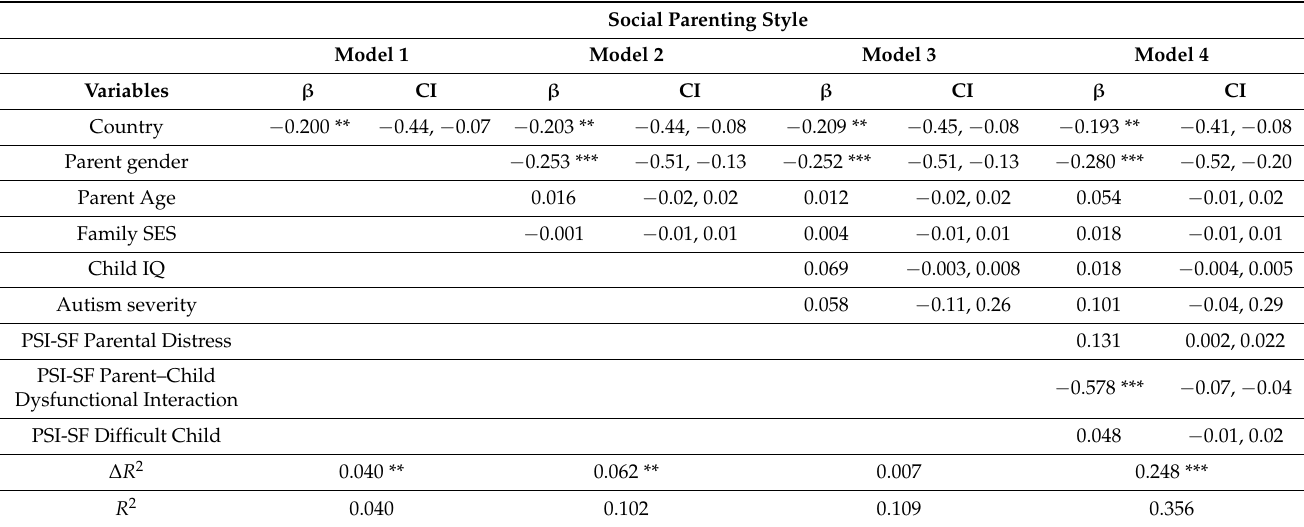
Table 4. Hierarchical regression predicting social parenting